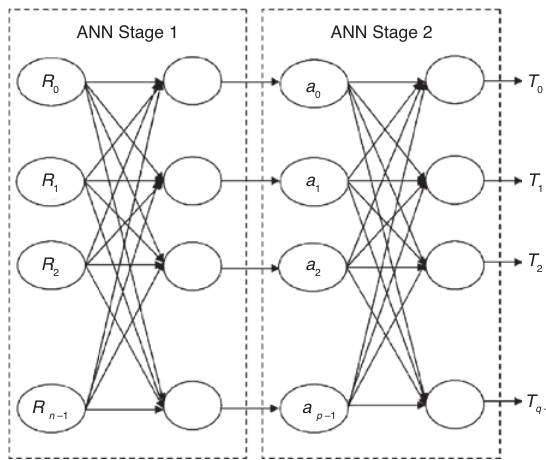
Figure 3: Dual-Stage